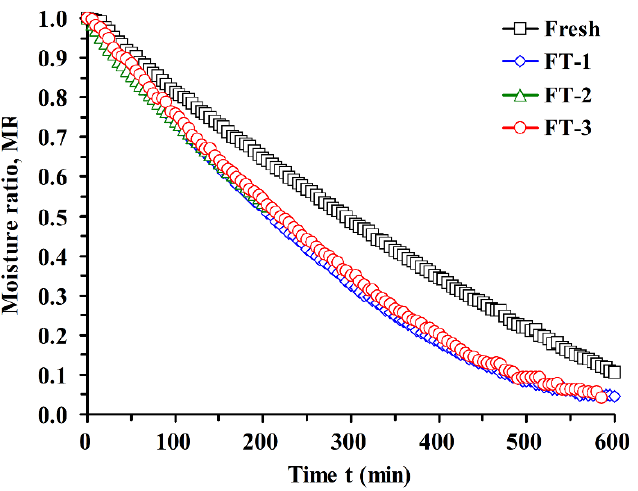
Figure 5. The hot-air drying curves of blueberry at 60 °C subjected to freeze-thaw (FT) treatments. FT-1, FT-2 and FT-3 represent the sample with FT treatment once, twice and third times. The D e value of the fresh blueberry sample is 2.69 × 10 − 10 m 2 /s, while the FT treated samples range between 4.43 × 10 − 10 and 4.59 × 10 − 10 m 2 /s, as shown in Table 3. The values